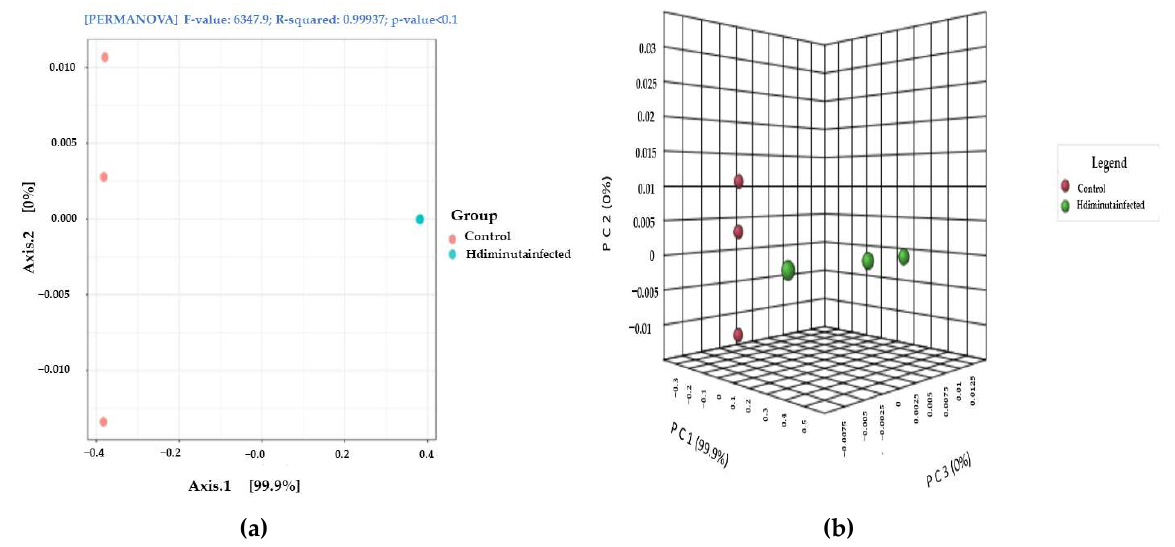
Figure 6. Beta diversity analysis: ( a ) PERMANOVA showing shifting of microbiome from Control to Infected; ( b ) 3-D PCA plot highlighted the shifting of microbiome. Comparative analysis between bacterial counts (filtered and log transformed) in control and infected hosts at different taxonomic levels was depicted in Figure 7. There is an observable difference between control and infected counts at the level of the Order Lactobacillales for both the filtered value and the log transformed value. The Welch t test confirms that this difference is significant at p -value = 0.09682 (for filtered) and p -value = 0.007957 (for Log transformed counts) (Figure 7a). Further, at the level of the Family Lactobacillaceae, there is again an observable difference between the bacterial loads (fil- tered and log transformed counts) in control and infected group. These differences are